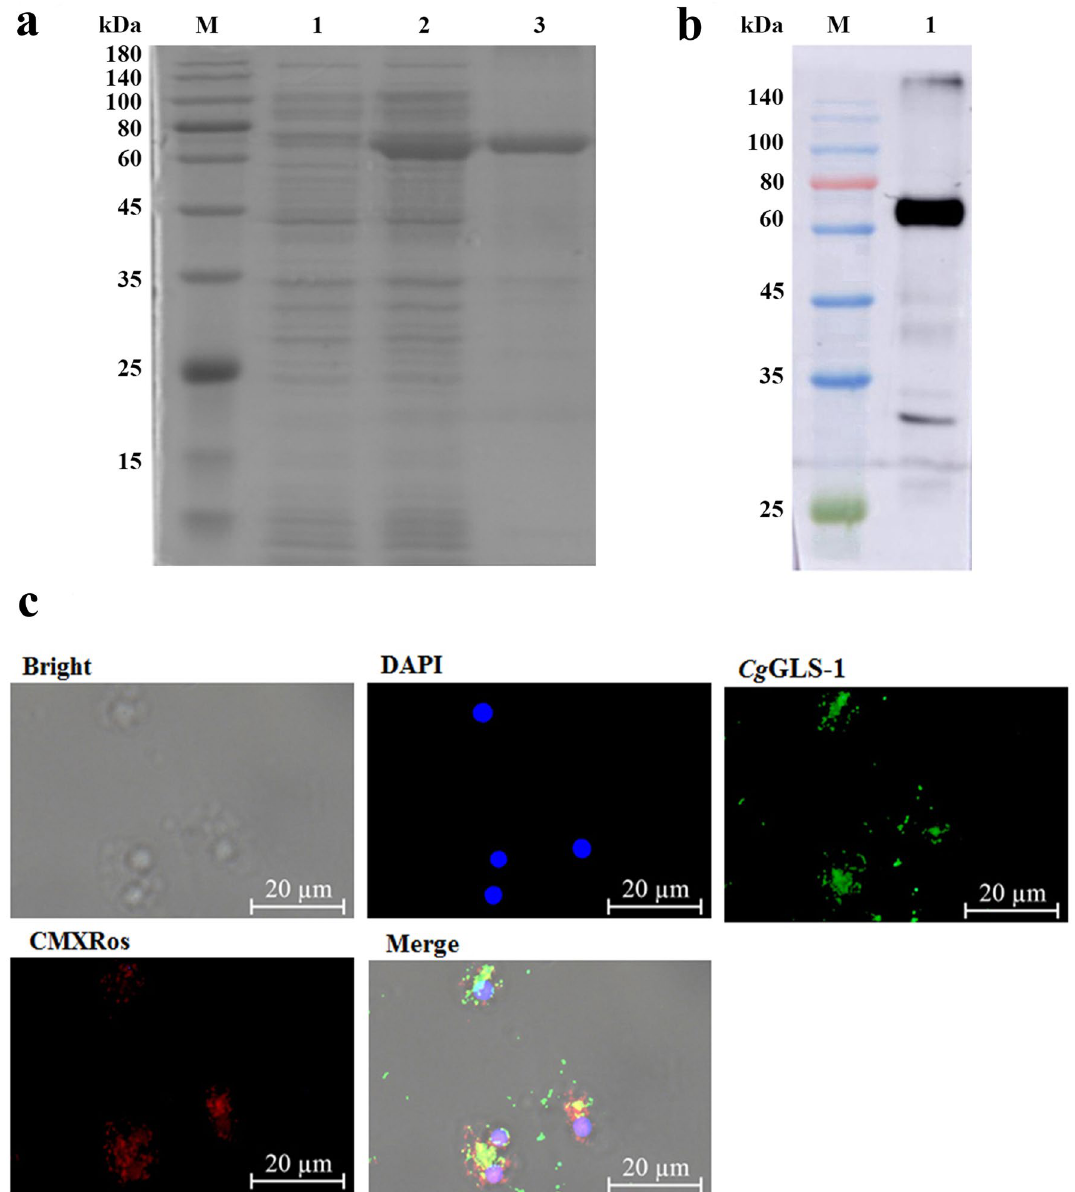
(kDa); Lane 1: negative control for r Cg GLS-1 (without induction); Lane 2: induced r Cg GLS-1; Lane 3: purified r Cg GLS-1. ( b ) Western blot analysis of anti -r Cg GLS-1. Lane M: protein molecular standard (kDa); Lane 1: Western blot based on the sample of Line 3. ( c ) Subcellular localization of Cg GLS-1 in C. gigas hemocyte. Nuclei staining with DAPI are shown in blue; anti -r Cg GLS-1 conjugated to Alexafluor 488 is shown in green; the cell mitochondria are stained by Mito-Tracker Red CMXRos and is shown in red. The scale bar is 20 μm. (Full- length blots/gels are presented in Supplementary Fig. 1 and